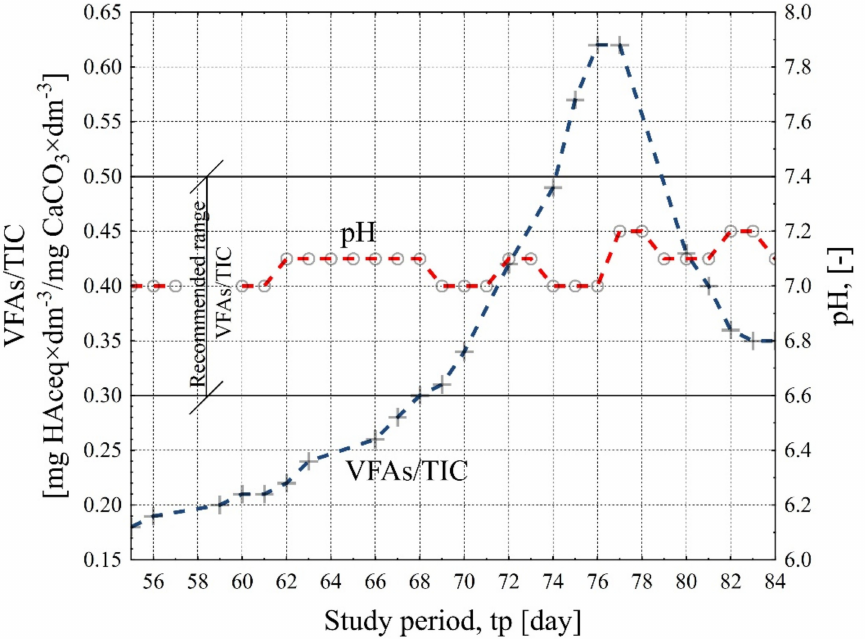
Figure 6. Graph of the change in the ratio of volatile fatty acids (VFAs) (mg HAceq/dm 3 ) and total inorganic carbon (TIC) (mg CaCO 3 /dm 3 ) depending on the duration of biogas plant start-up using inoculated